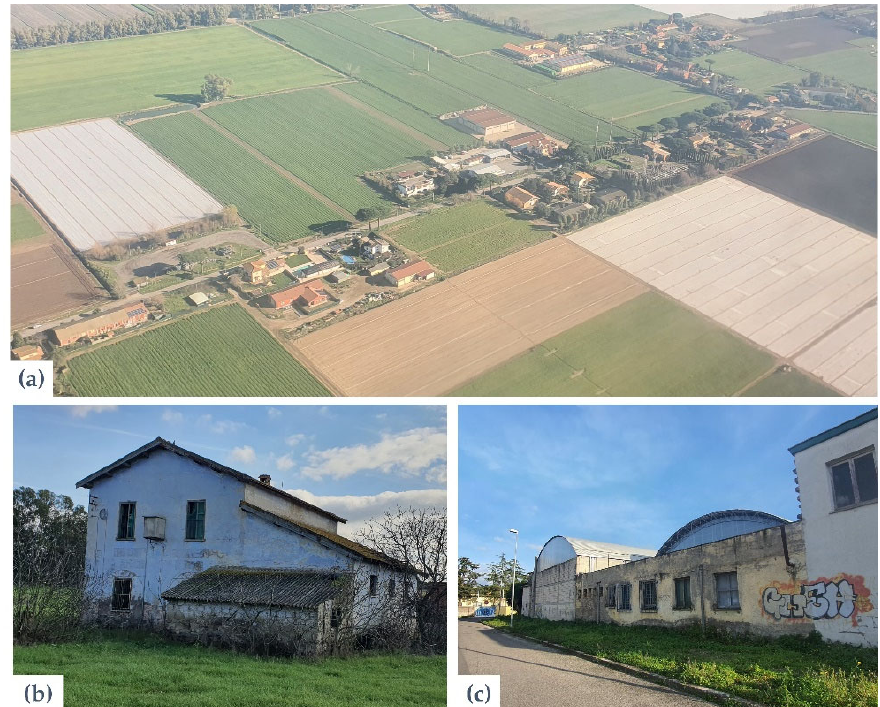
Figure 7. Some characteristics of rural settlements’ built environment in the Lazio region (images taken by Ahmed Abouaiana). ( a ) Aerial view of a typical scattered urban fabric of rural and suburban agricultural areas, Rome province; ( b ) an abandoned original dwelling of 1930s architecture, Pontinia settlements. This typology (static mass) is suitable for plain topography and is predominate in the Lazio region; ( c ) Original industrial buildings in Pontinia. As seen, the roof is a light structure (fiber cement) of so-called in Italian “ eternit ”, which is predominate in many dwellings (mainly outside the inhabited center, as has been observed in the field survey), farm buildings, and sheds.